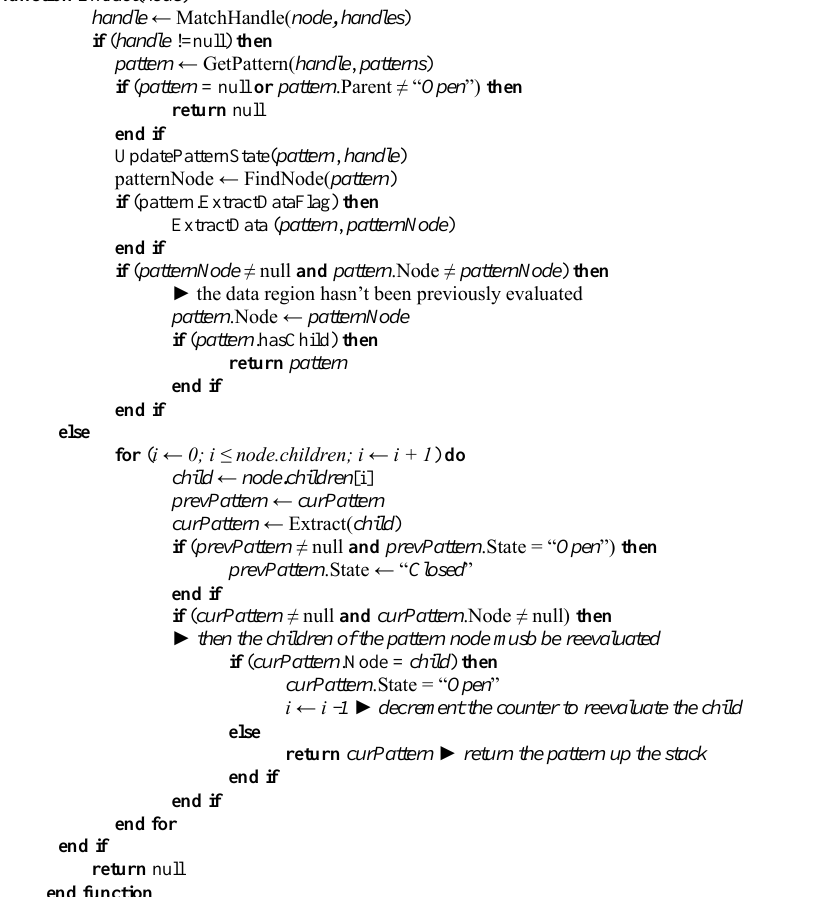
Algorithm 1 Data Extraction